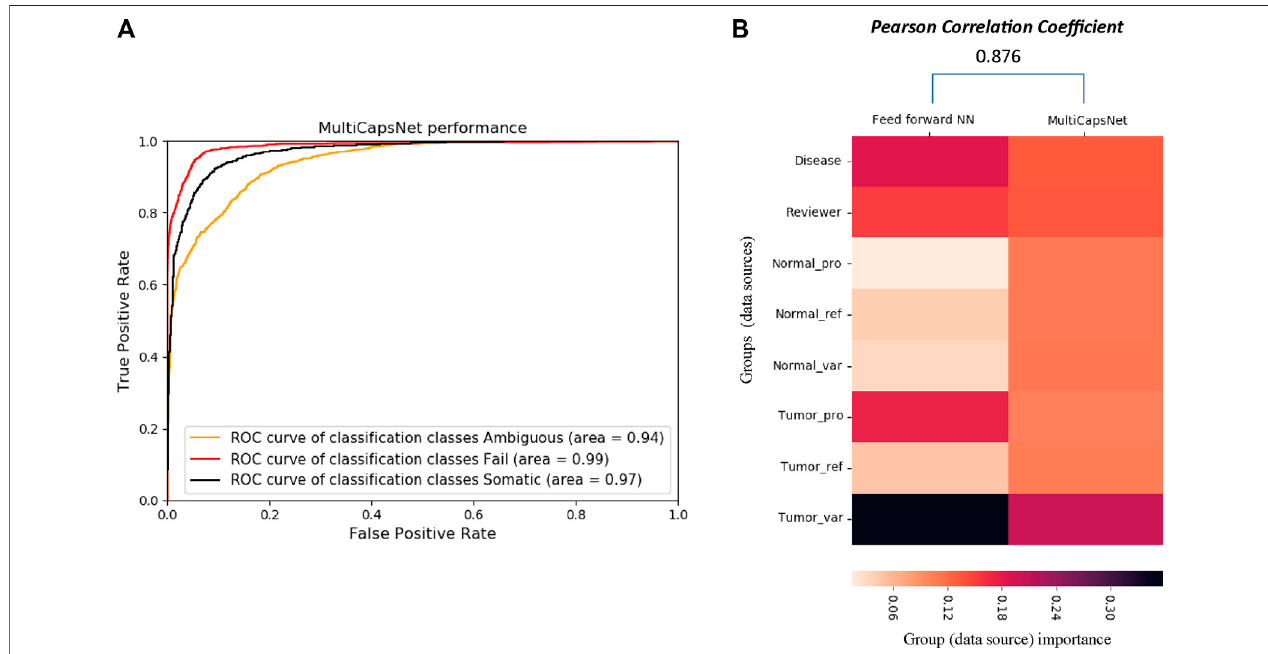
FIGURE 3 | Architecture of MultiCapsNet integrated with prior knowledge. (A) The model has two layers. The fi rst layer consists of 696 parallel neural networks corresponding to696 primary capsules labeled with either transcription factor (348) or protein-protein interactioncluster node (348). The inputs ofeach primary capsule include genes regulated by a transcription factor or in a protein-protein interactions sub-network. The second layer is the Keras implementation of CapsNet for classi fi cation. The length of each fi nal layer type capsule represents the probability of input data belonging to the corresponding classi fi cation category. (B) Alternative representation of MultiCapsNet integrated with prior knowledge. Genes that are regulated by a transcription factor or in a protein-protein interactions sub-network, are groups together as a data source for MultiCapsNet. Figures 3A,B are equivalent with different representation.